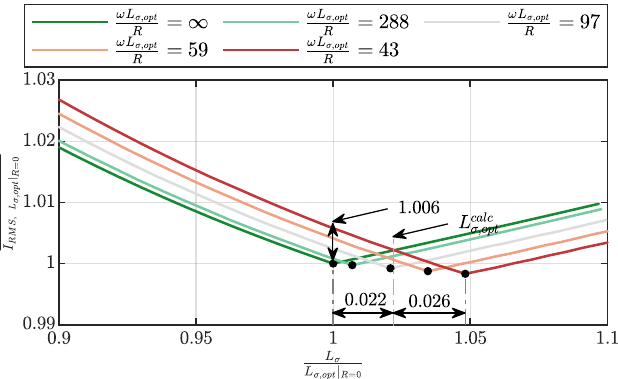
Figure 13. The maximum of the currents in the operation domain as a function of the leakage inductance for different ω L σ / R ac values obtained from the simulation model for ( σ p , σ s ) = ( 0.1, 0.1 ) . The dashed blue line marks the value of L σ ,opt from the analytical formula ( L calc σ ,opt ). As seen, a 4.8% error in L σ ,opt will cause a less than 1% error in the RMS value of the current. The value of L σ ,opt from the analytical formula is depicted with a dashed blue